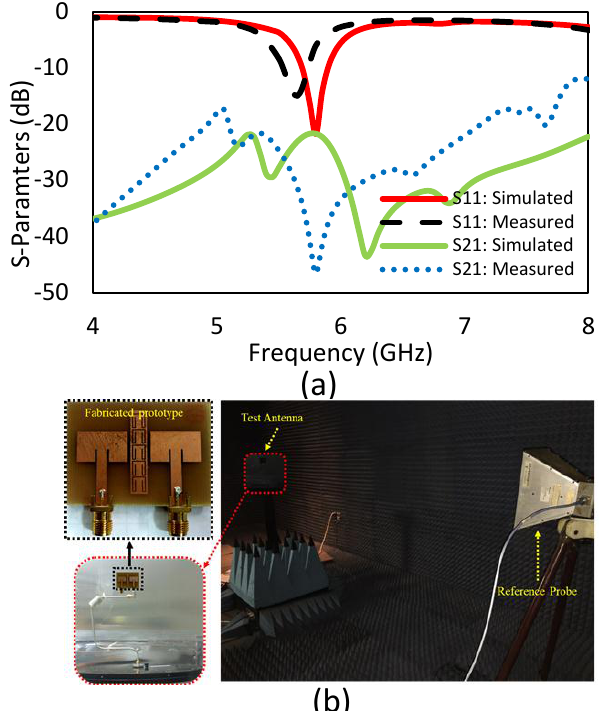
Figure 7. ( a ) Measured and simulated S-Parameters of the designed MIMO antenna, ( b ) Radiation pattern setup and fabricated